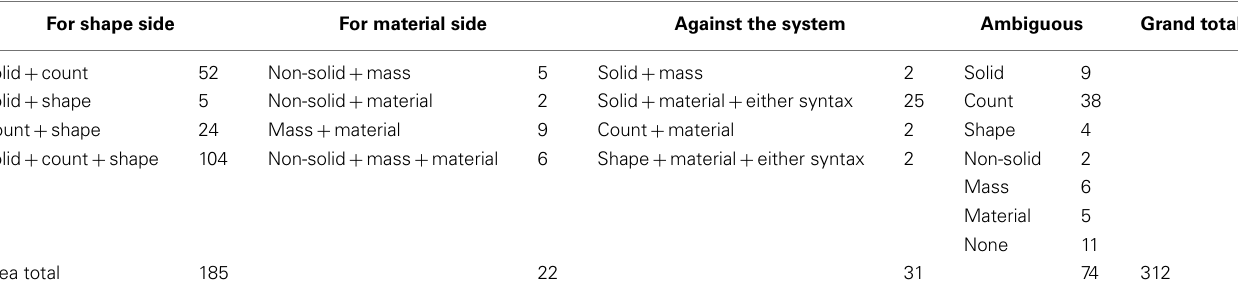
Table 3 | Number of MCDI nouns in each classification per area based on Samuelson and Smith’s (1999) adult judgments of solidity, syntax, and category